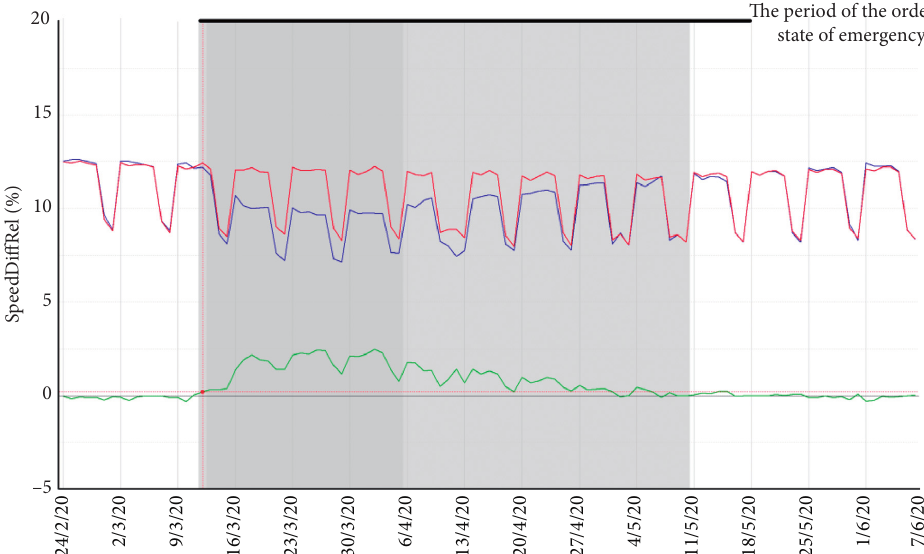
Figure 6: Deviation of the measured and predicted speed values from FreeFlowSpeed for residential area roads in the period from 24 February to 7 June 2020. These are the daily average values.